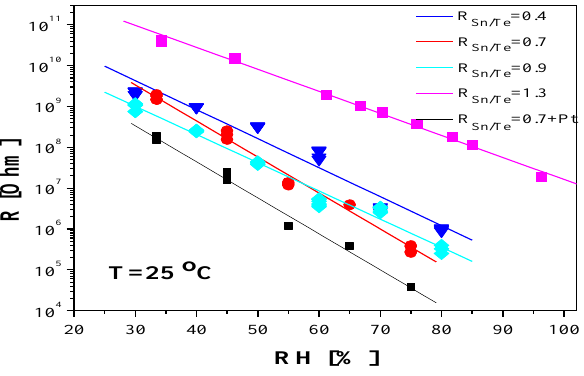
Figure 5. R [Ω] as a function of relative humidity RH [%] for layers with R